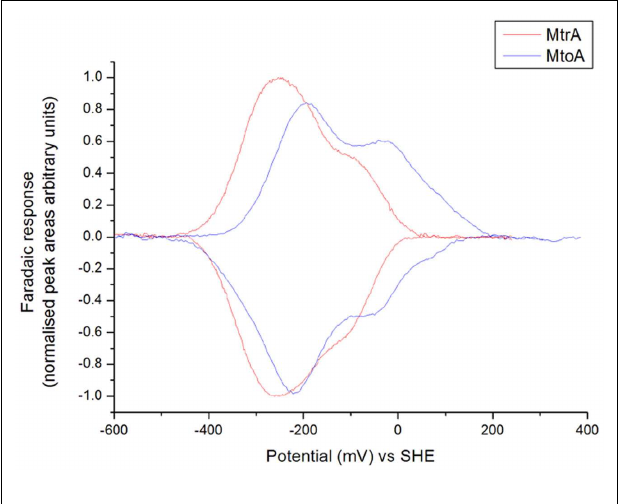
FIGURE 4 | Cyclic voltammograms of MtoA of Sideroxydans lithotrophicus ES-1 and MtrA of Shewanella oneidensis MR-1 adsorbed on graphite electrodes. Scan rate = 50mV/s, buffer-electrolyte = 25mM HEPES pH 7.1 with 100mM NaCl, T = 277K.